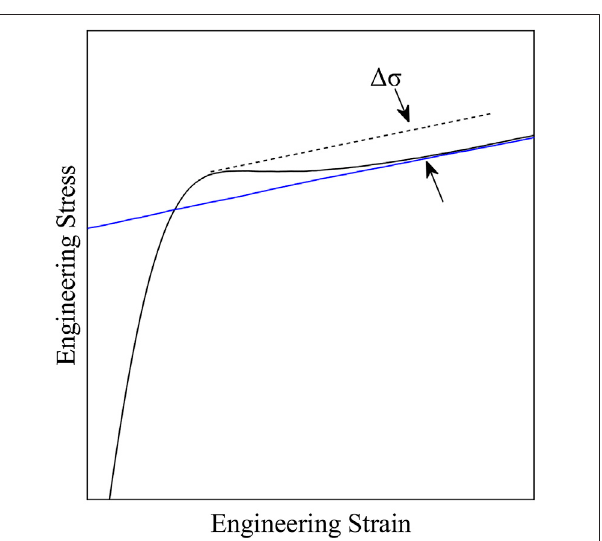
FIGURE 4 | Change in yielding ( Δ σ ), shown as the difference between the upper yield point and the stress at the strain of the maximum yield assuming the work hardening rate of the sample after yielding.